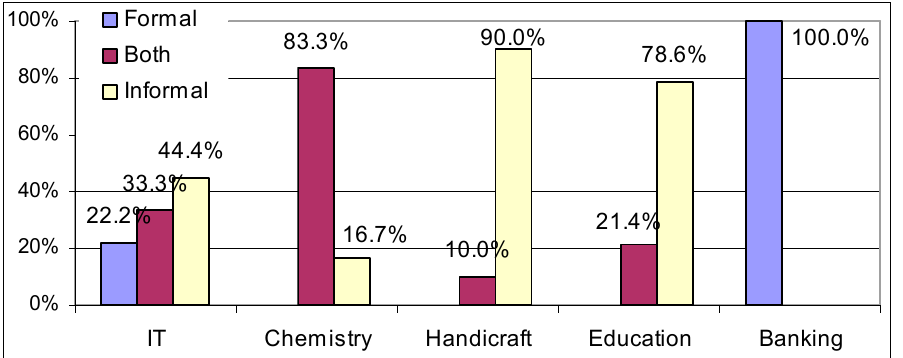
Figure 2. Distribution of opinions about the predominance of the formal or informal knowledge for the value creation in the business.